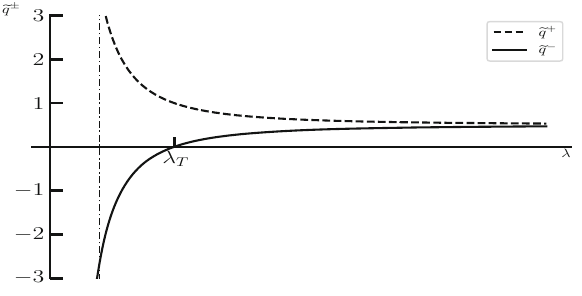
Fig. 2 The transition scale λ T applied here to an Einstein–de Sitter background with q = 1 / 2. On scales much larger than λ T the relative- motion effects are negligible and ˜ q ± → 1 / 2. Scales close and inside the transition scale, on the other hand, are heavily contaminated by the observers peculiar motion. There, ˜ q + becomes increasingly more posi- tive (dashed curve), while ˜ q − turns negative at λ T and keeps decreasing on smaller wavelengths (solid curve). The vertical line marks the non- linear cutoff, where the linear approximation breaks